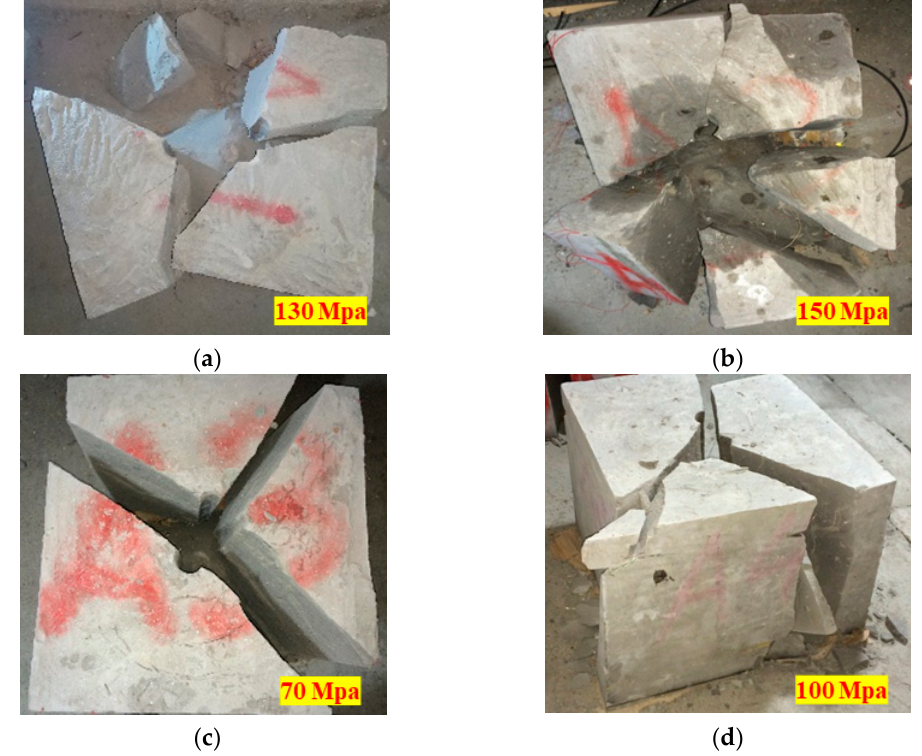
Figure 7. Graph of blast results for Group A specimens. ( a ) A-1 specimen after blasting; ( b ) A-2 specimen after blasting; ( c ) A-3 specimen after blasting; ( d ) A-4 specimen after blasting.